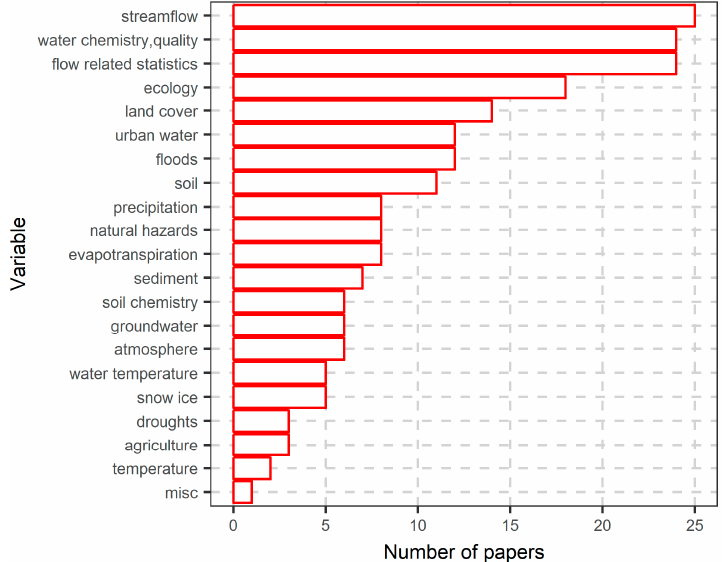
Figure 7. Number of published RF-related papers conditioned on the examined variable.